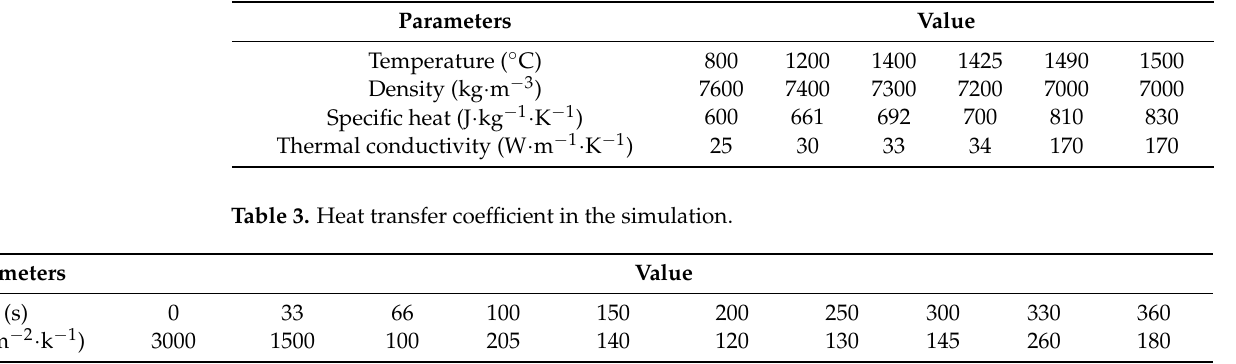
Table 2. Simulation parameters.